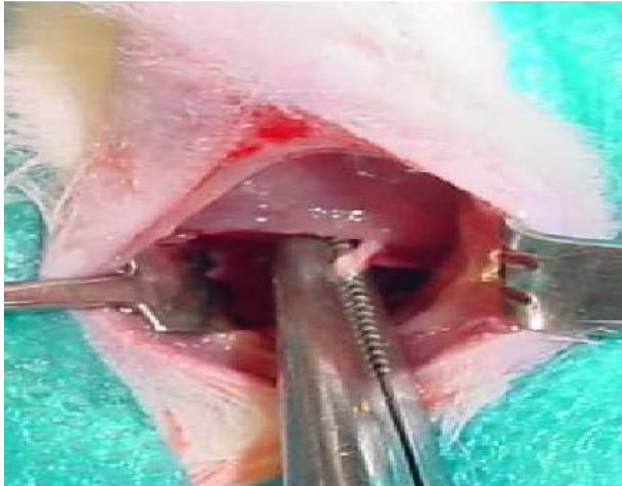
FIGURE 1 – Damage to the sciatic nerve by standard compression